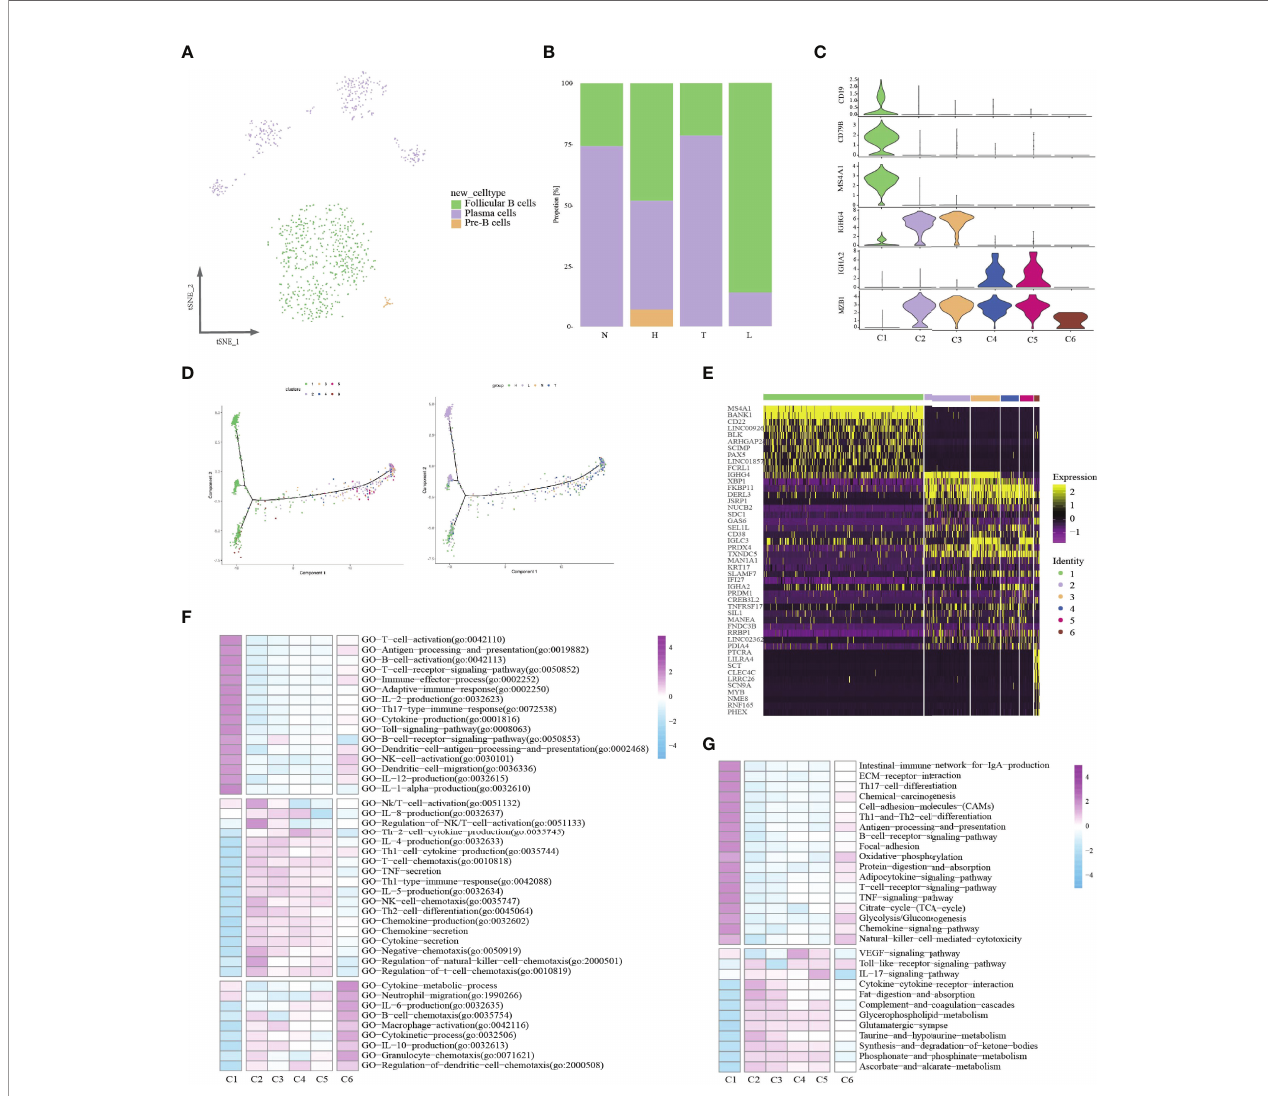
FIGURE 6 | Identifying distinct B cell clusters in all samples. t-SNE projection of three cell types of B cells (each dot corresponds to one single cell) shown in different colors (A) . Proportions of all cell types clusters among four groups (B) . Violin plots representing the distribution module score for selected genes for each cluster. Error bars indicated the means ± SD (C) . Trajectory of all B cell clusters along pseudotime in a two-dimensional state-space de fi ned by Monocle2. Each point corresponds to a single cell (D) . Heatmap indicating differently genes among six clusters (E) . Heatmap showing the enrichment of biological function in six B cell clusters (GSVA GO) (F) . Heatmap showing the enrichment of biological function in six B cell clusters (GSVA KEGG) (G)